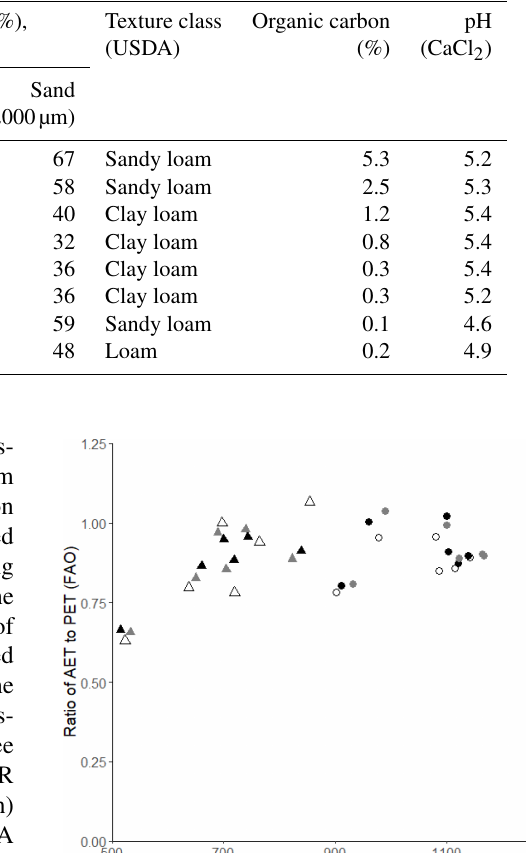
Table 1. Soil properties at Rollesbroich.